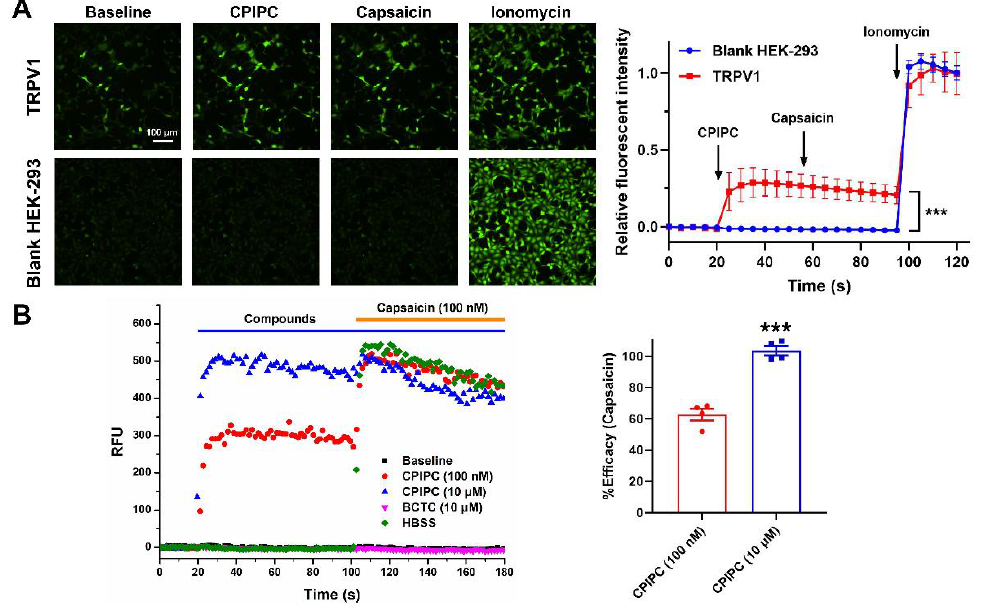
Figure 2. CPIPC induces Ca 2+ influx in TRPV1 transiently transfected HEK293 cells. ( A ) Left: calcium-imaging of TRPV1 transiently transfected or blank HEK293 cells after treatment with CPIPC (1 µ M), capsaicin (1 µ M) and ionomycin (10 µ M). Scale bar: 100 µ m. Right: relative fluorescent intensity of Fluo-8 induced by CPIPC , capsaicin and ionomycin in TRPV1-expressing HEK293 cells (red square) and non-transfected cells (blue circle). The results of relative fluorescent intensity were calculated based on 45 cells in a glass coverslip ( n = 45). Fluorescence intensity was normalized with the maximal value of ionomycin (10 µ M). ***, p < 0.001. ( B ) Left: 100 nM (red) and 10 µ M (blue) CPIPC - induced intracellular calcium rise and 10 µ M BCTC (green, TRPV1 antagonist) blocked the activation effect of 10 µ M CPIPC on TRPV1 channels in TRPV1-expressing HEK-293 cells in FlexStation 3 calcium fluorescence assay. Right: the efficacy of CPIPC (100 nM and 10 µ M). Normalized by Capsaicin (100 nM) in FlexStation 3 calcium fluorescence assay ( n = 4). ***, p < 0.001. RFU: Relative Fluorescence Unit.